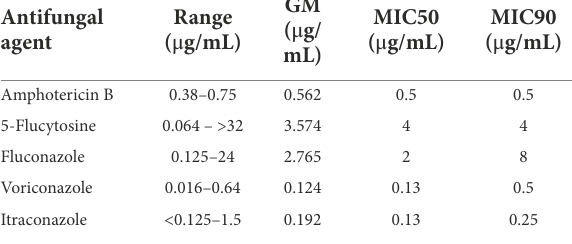
TABLE 1 Antifungal susceptibilities of five antifungal agents.